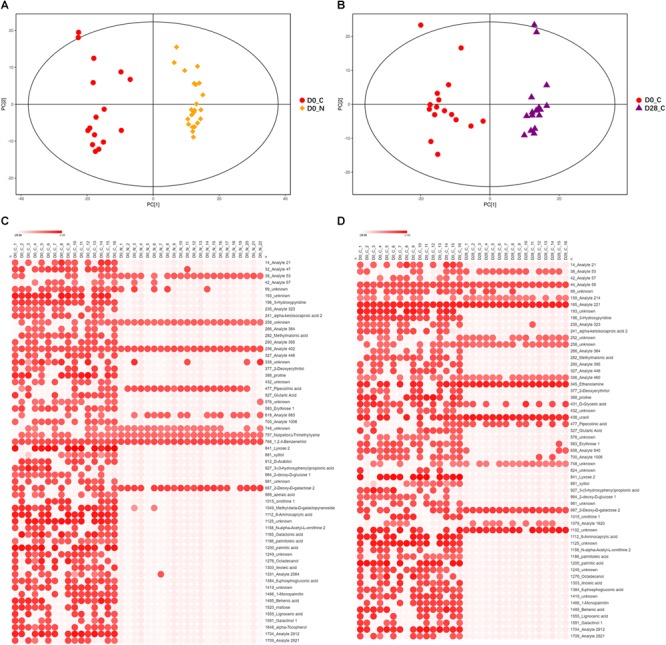
Differences of non-volatile fecal metabolites among subject groups. (A) PCA score scatter plot of constipated subjects and non-constipated subjects on D0 (R2X = 0.516, PC1 = 14.00%). (B) PCA score scatter plot of constipated subjects before and after LcS intervention (D0 vs. D28, R2X = 0.520, PC1 = 11.90%). (C) Heatmap of 58 significantly differential non-volatile fecal metabolites between constipated subjects and non-constipated subjects (VIP > 1 and p < 0.1). (D) Heatmap of 57 significantly differential non-volatile fecal metabolites in constipated subjects before and after LcS intervention (VIP > 1 and p < 0.1). D0_N, non-constipated subjects on D0; D0_C, constipated subjects on D0; D28_C, constipated subjects on D28. In Heatmap, x-axis indicated samples and y-axis indicated significant differential metabolites. The color scale represented the logarithm value of relative abundance with base 2 of metabolites.